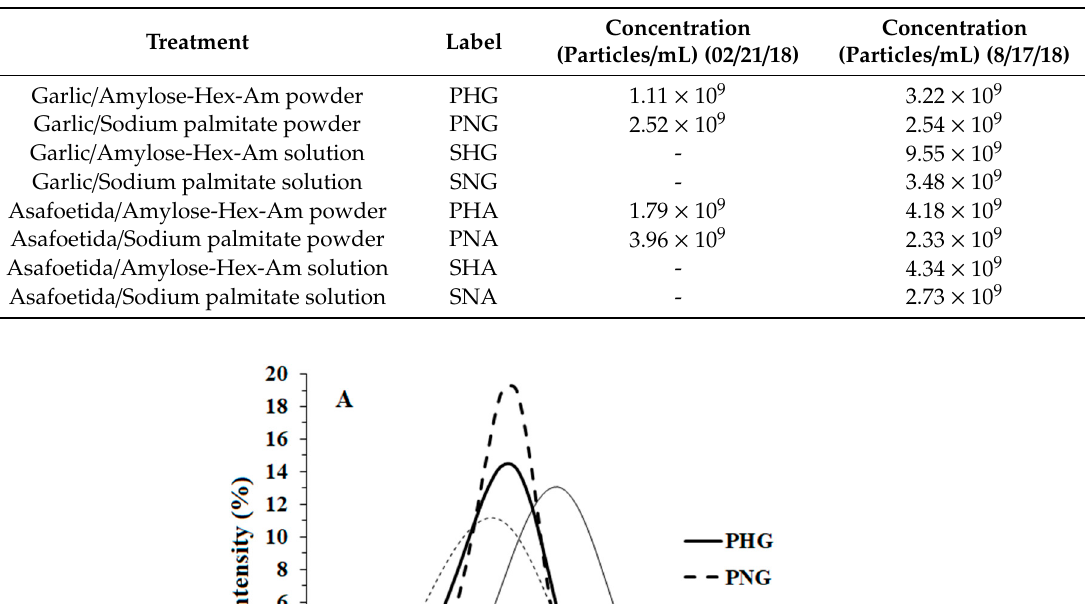
Table 2. Droplet numbers of garlic and asafoetida essential oil emulsions. Samples were diluted in de-ionized water at 1:1000. Dash (-) indicates that droplet numbers were not determined.